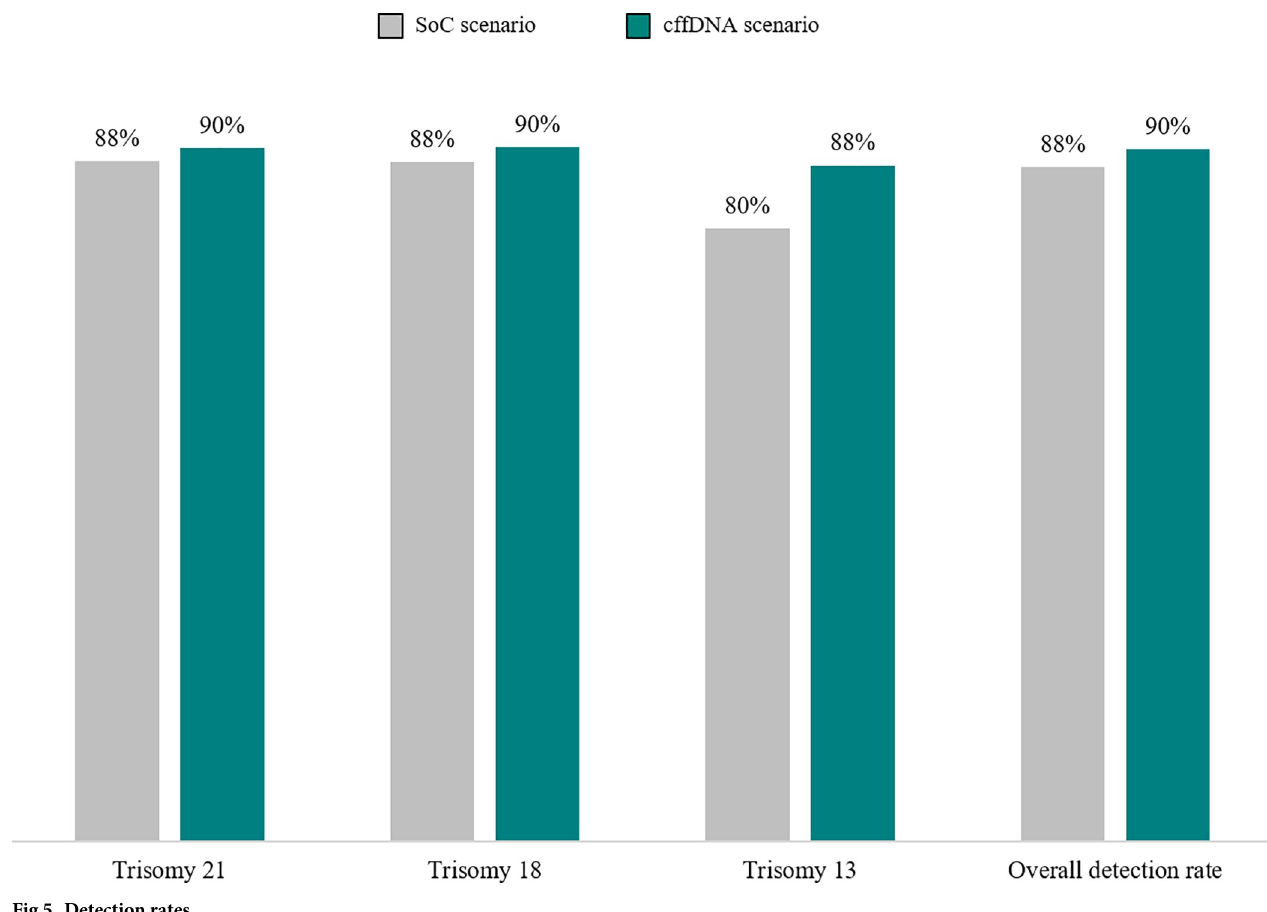
Fig 5. Detection